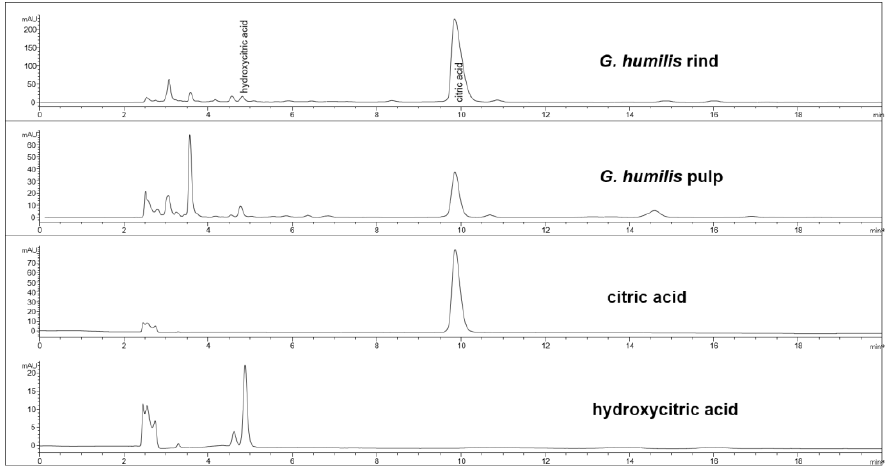
Figure 2. HPLC chromatogram from G. humilis rind and pulp, and citric and hydroxycitric acids at 210 nm.